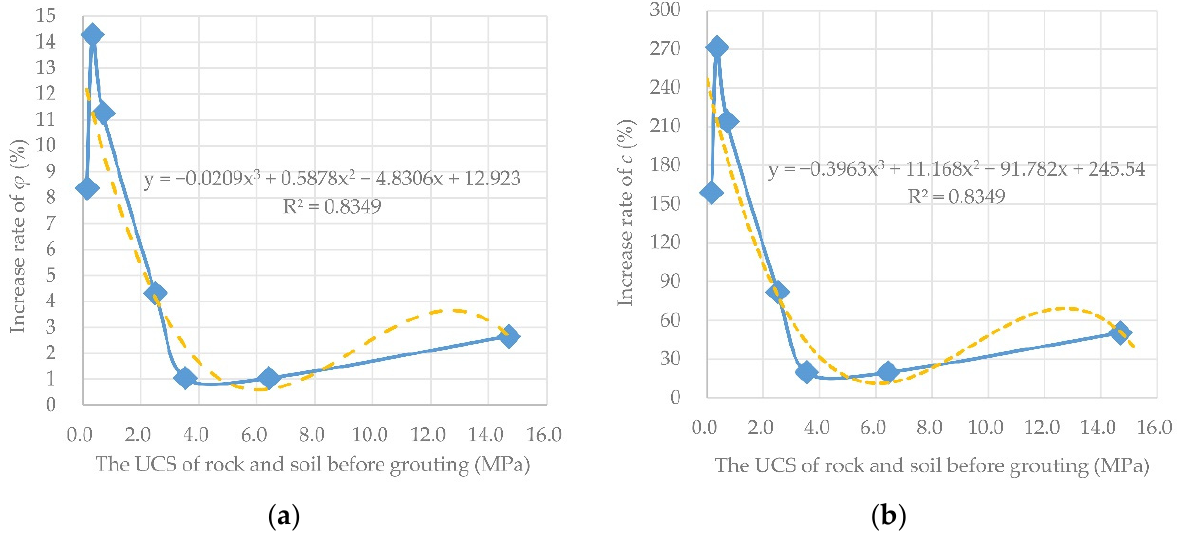
Figure 9. Relationship between the UCS of rock and soil before grouting and the shear strength parameter increase rate of rock and soil after grouting when water–cement ratio η = 1: ( a ) Relation between the increase rate of ϕ and the UCS of rock and soil before grouting; ( b ) relation between the increase rate of c and the UCS of rock and soil before grouting.